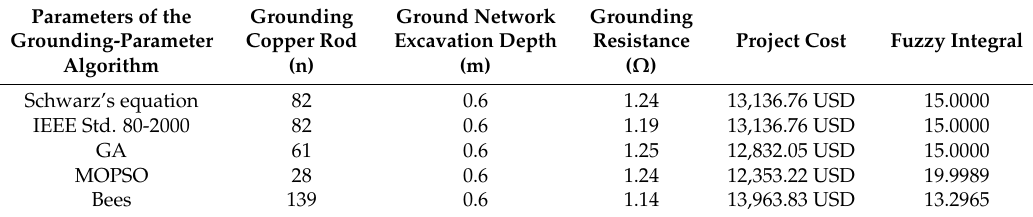
Table 1. Fuzzy integrals of grounding data for each algorithm in the fixed network laying depth. Parameters of the Grounding-Parameter